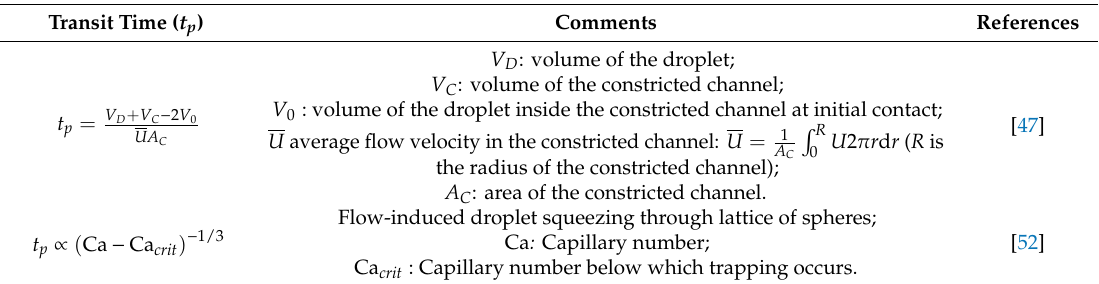
Table 6. Analytical expressions available in the literature for the transit time of a bubble / droplet passing through a microfluidic